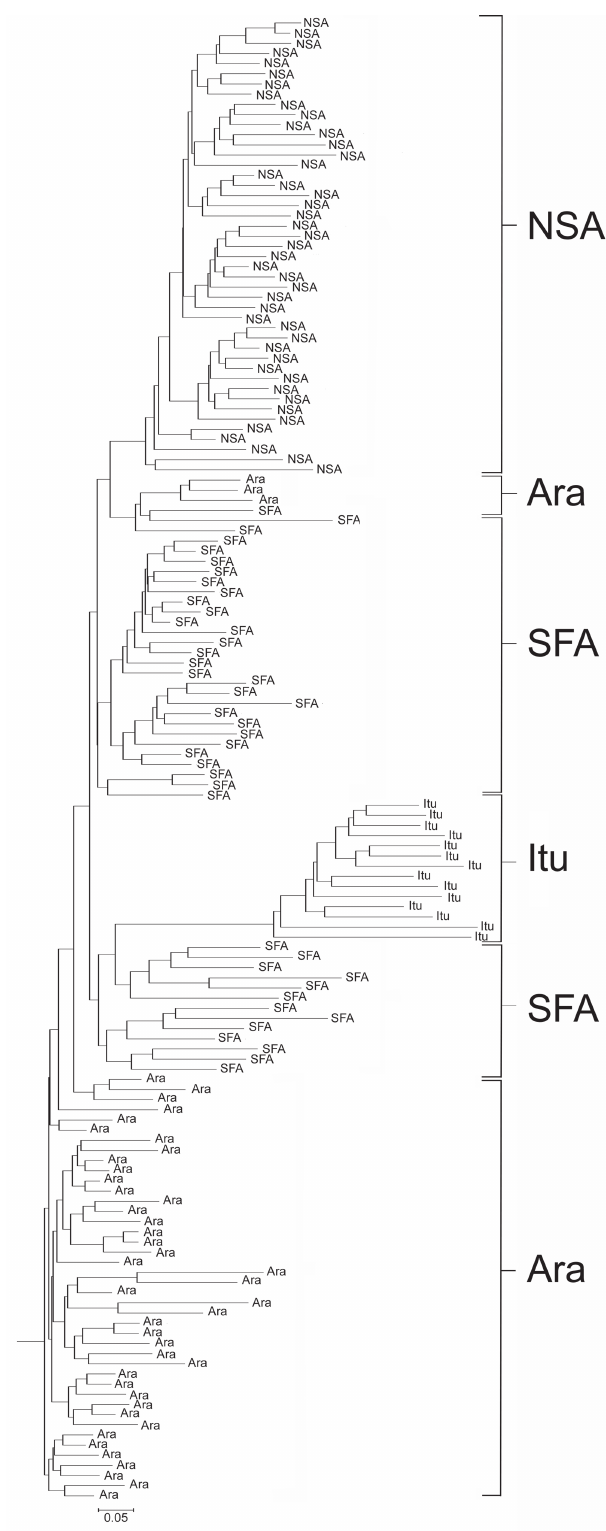
Fig. 4. Neighbor-joining dendrogram of Arapaima gigas generated with data from ISSR based on Jaccard similarity index with 10,000 bootstrap. (Ara) Araguaiana-MT, (NSA) Novo Santo Antônio-MT, (SFA) São Félix do Araguaia-MT and (Itu)